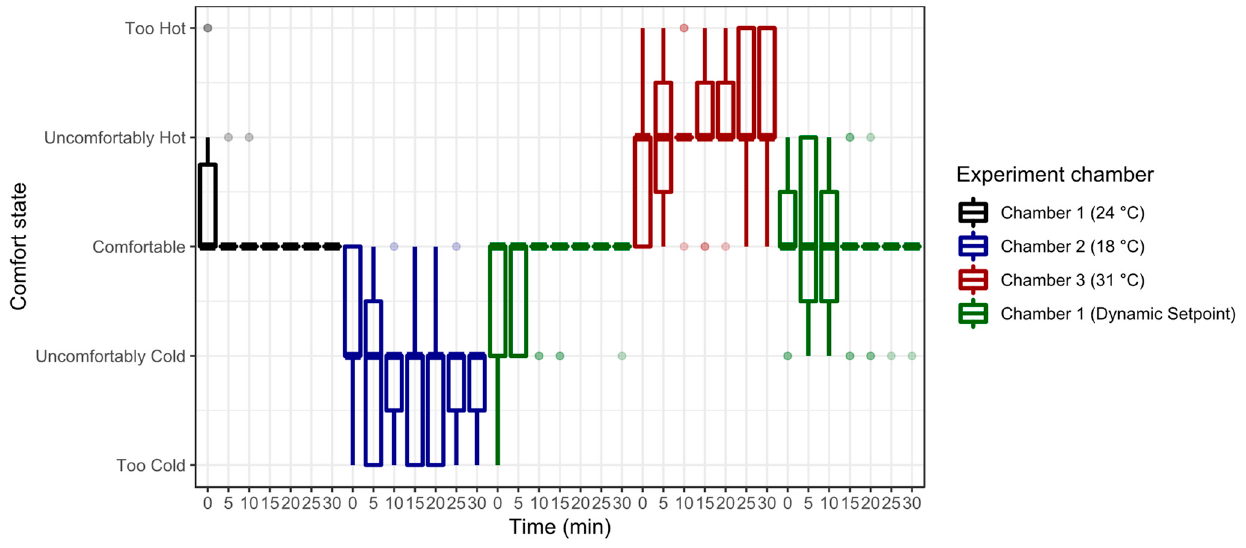
Figure 7. Comfort survey results at every 5-min interval. The last 30 min of Phase 3 (a 60-min interval designed to permit longer physiological recovery from thermal stress) has been removed for consistency.